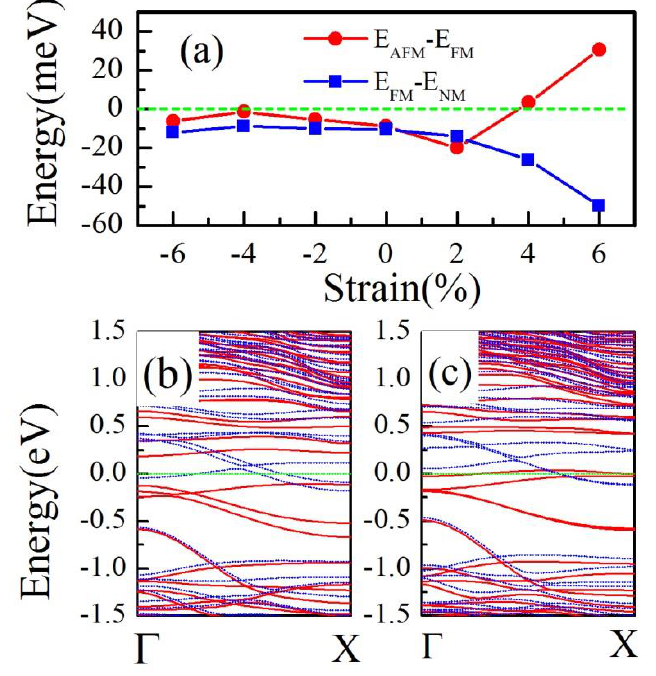
Figure 4. ( a ) Energy difference between nonmagnetic (E NM )/anti-ferromagnetic (E AFM ) and ferromagnetic (E FM ) as a function of strain. ( b ) The spin-polarized band structure of 9- a -TiS 3 NR under 6% tensile strain. ( c ) The spin-polarized band structure of 10- a -TiS 3 NR under 6% tensile strain.